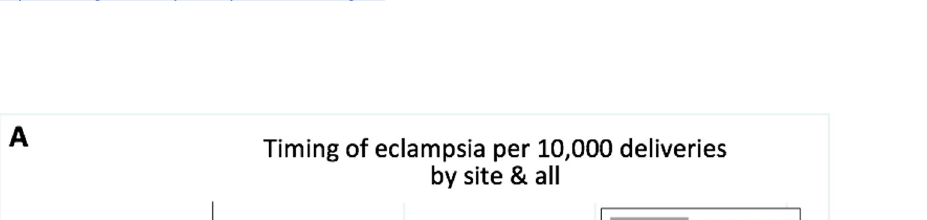
Fig 1. Rates of eclampsia and maternal deaths and intensive care unit (ICU) admissions from hypertensive disorders of pregnancy (HDP) by site. Data shown for eclampsia (A), maternal deaths from HDP (B), and ICU admissions from HDP (C). ICU admissions shown for sites with ICU available. Corresponding numbers are given in S2 and S3 Tables.